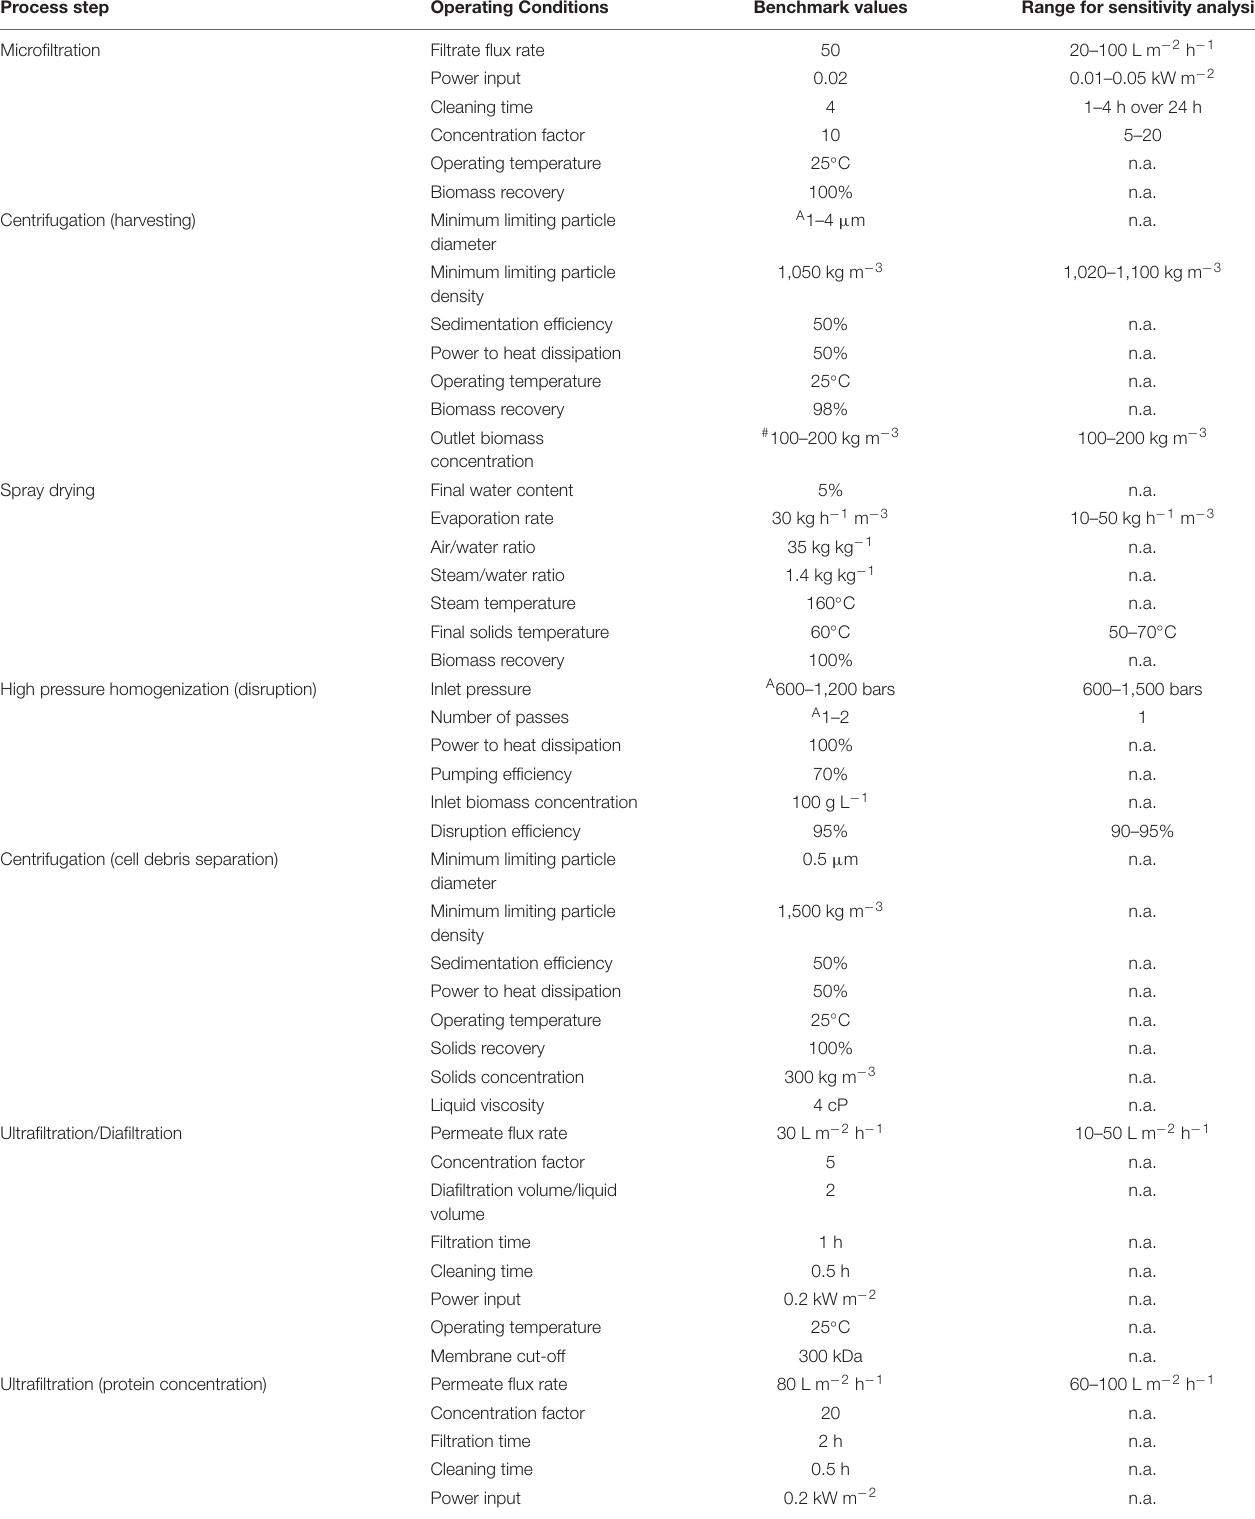
TABLE 1 | Operating conditions for the biorefinery process steps for benchmark conditions and as used in sensitivity